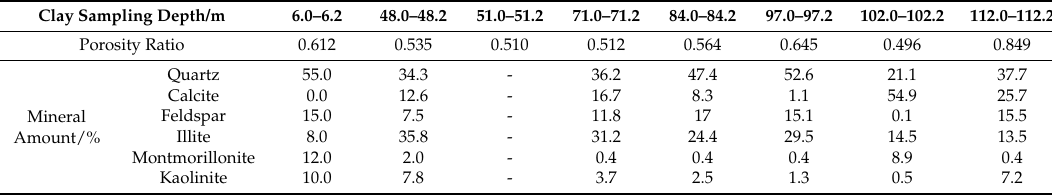
Table 2. Basic physical and chemical properties of the clay samples.